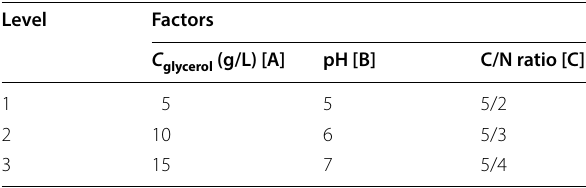
Table 5 Levels of selected factors for orthogonal experimental design